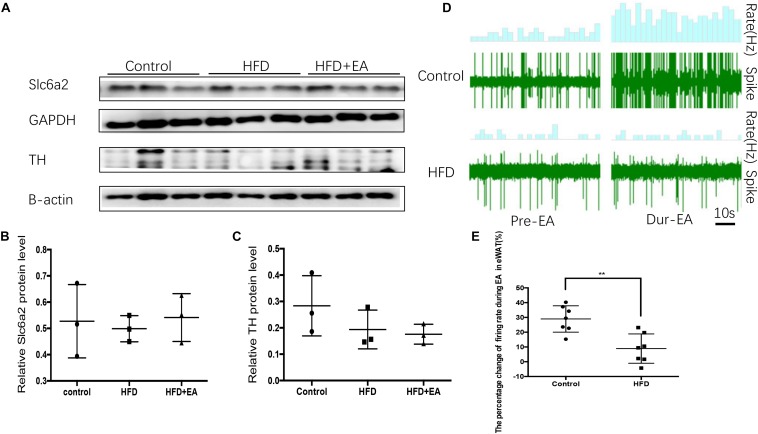
Effect of EA on the SNS-macrophage cross-talk shows in iWAT but not in eWAT. (A) Immunoblot image showing Slc6a2 and TH in eWAT. (B) Relative protein level of Slc6a2 (in the control, HFD, and HFD + EA groups) (n = 3, P > 0.05). (C) Relative protein level of TH (in the control, HFD, and HFD + EA groups) (n = 3, P > 0.05). (D) Waveform representing spontaneous discharge in eWAT during EA in the control and HFD group. (E) Percentage change in the firing rate of eWAT during EA in the control and HFD group (n = 6, **P < 0.01).